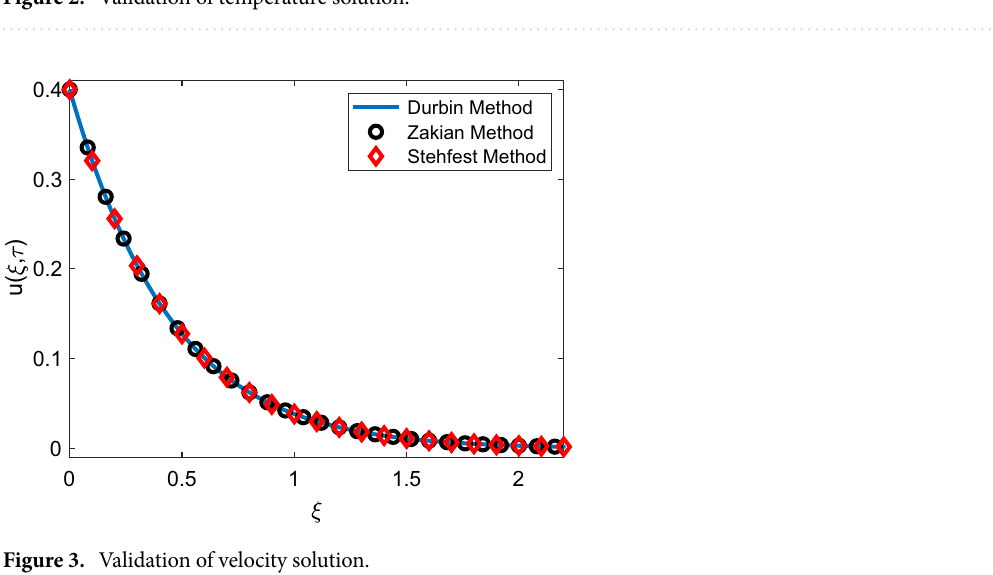
Figure 2. Validation of temperature solution.